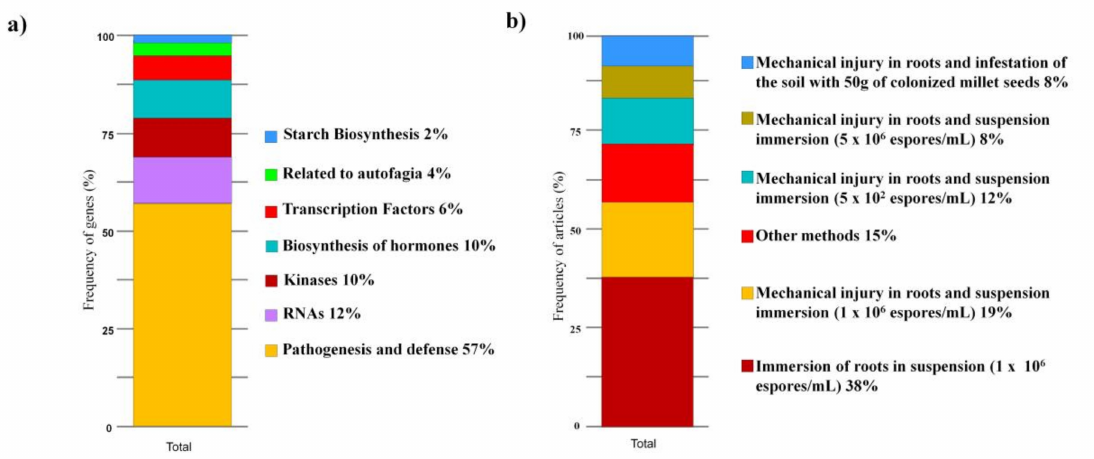
Figure 10. Gene expression studies of banana plants infected with Fusarium oxysporum f. sp. cubense in articles carried out in the last ten years. Categories of genes associated with the frequency of articles ( a ) and frequency of methods used for inoculation of plants to check gene expression ( b